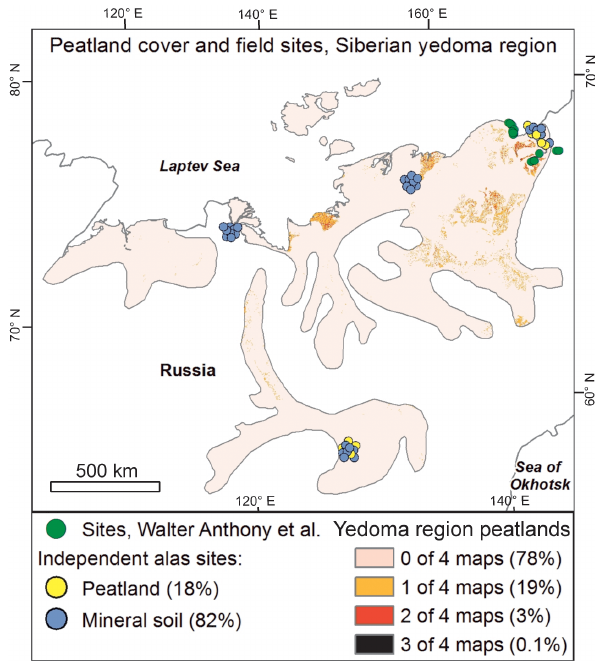
Figure 1. Overview of field sites and estimated coverage of peat- lands in the Siberian Yedoma region. Graduated colors within the region show coverage of peatlands in four global and/or regional map products that are independent from the NCSCD (see online supplementary material for detailed methods). The coverage is shown cumulatively so that the colors reflect how many of the four products that map peatlands in any given location. Points show lo- cations of the Holocene alas profiles used by Walter Anthony et al. (2014) as well as independent soil profiles for validation (classi- fied as mineral soils or peatlands). All of the independent validation points are known to be located in alases or thermoerosional gul- lies. Extent of the Siberian Yedoma region digitized from Grosse et al.